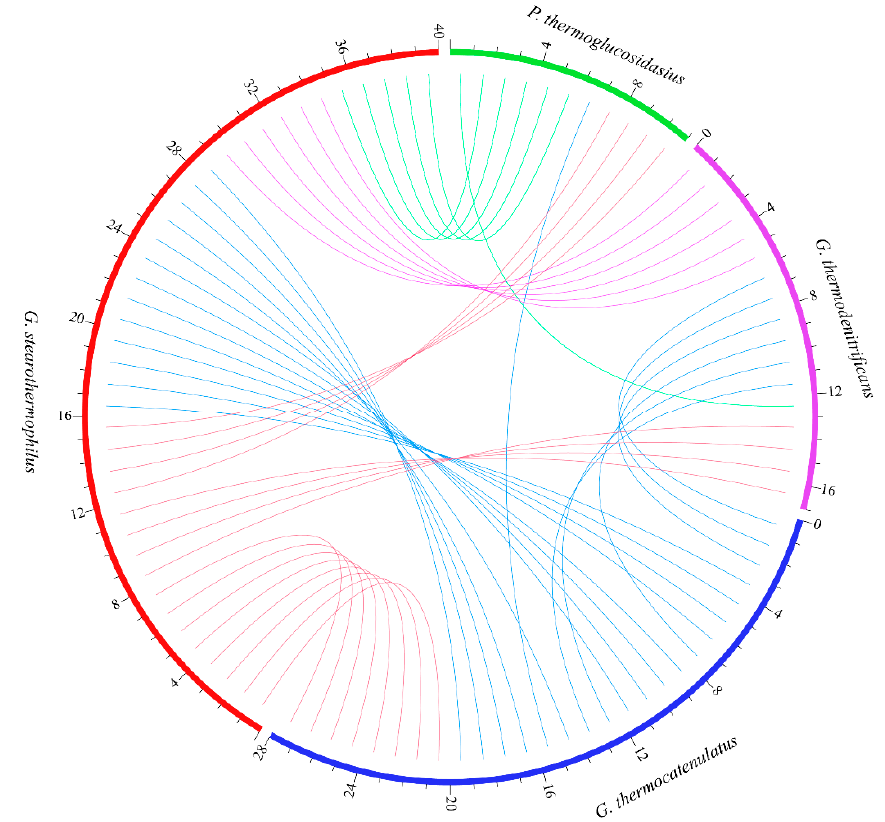
Figure 5. The predicted horizontal gene transfer (HGT) events between different species. Bands connect the two species where HGT events occurred, and the outmost digits are the HGT events numbers within each species.